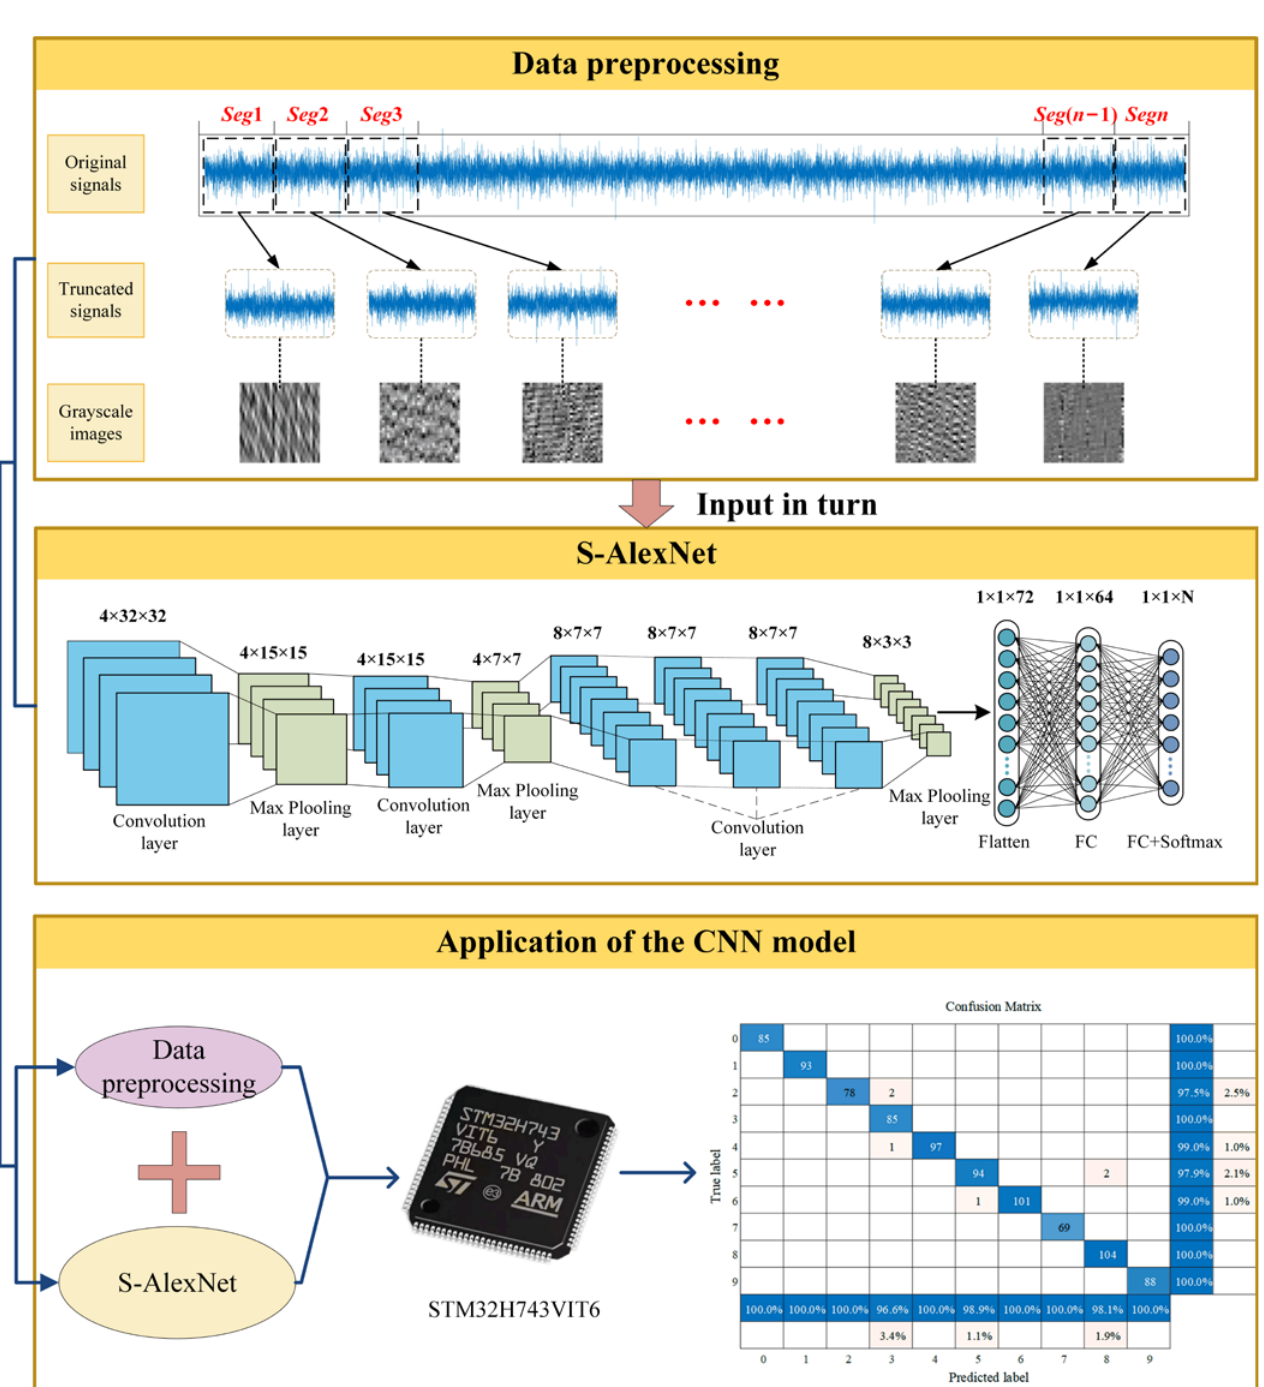
Figure 1. Intelligent fault diagnosis CNN model.